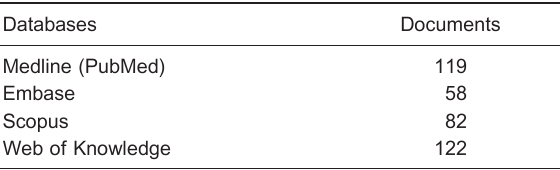
Table 1. Distribution of editorials in the four databases (January 1989-August 2011).